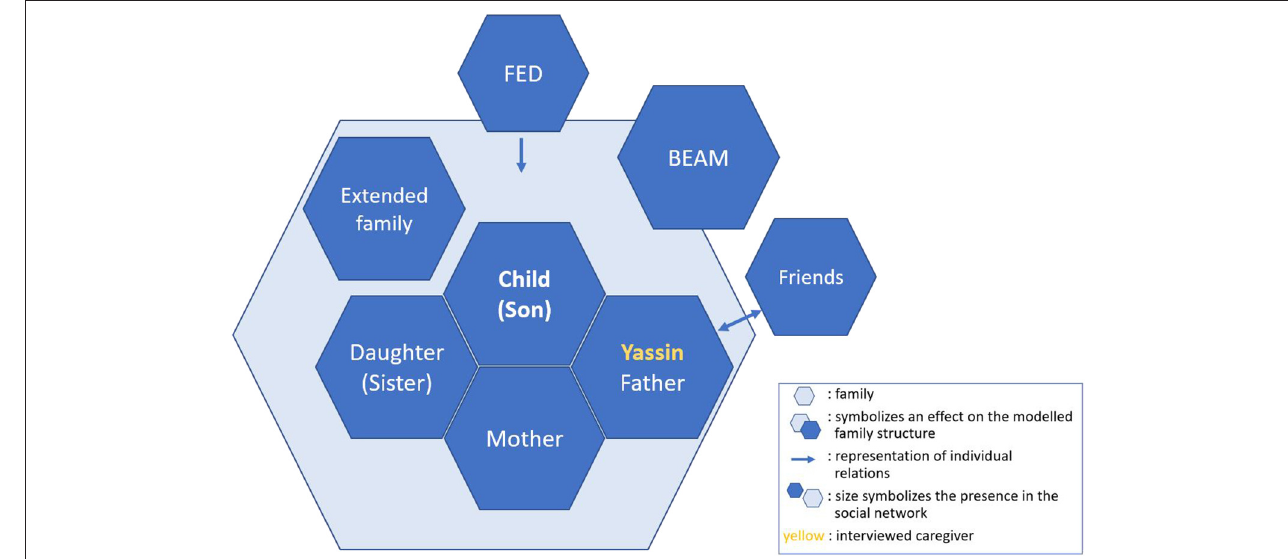
FIGURE 3 | Yassin’s social